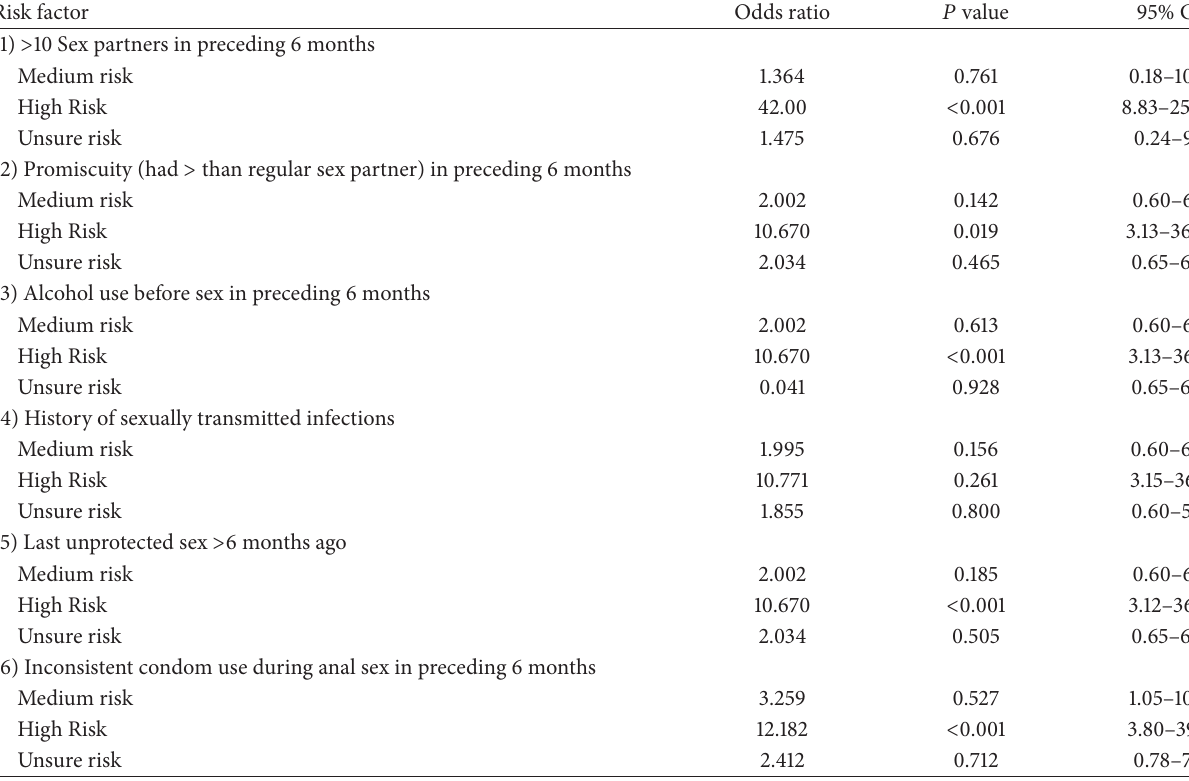
Table 3: Odds of testing HIV positive in each perceived risk group for each of the risk factors using “low risk” as